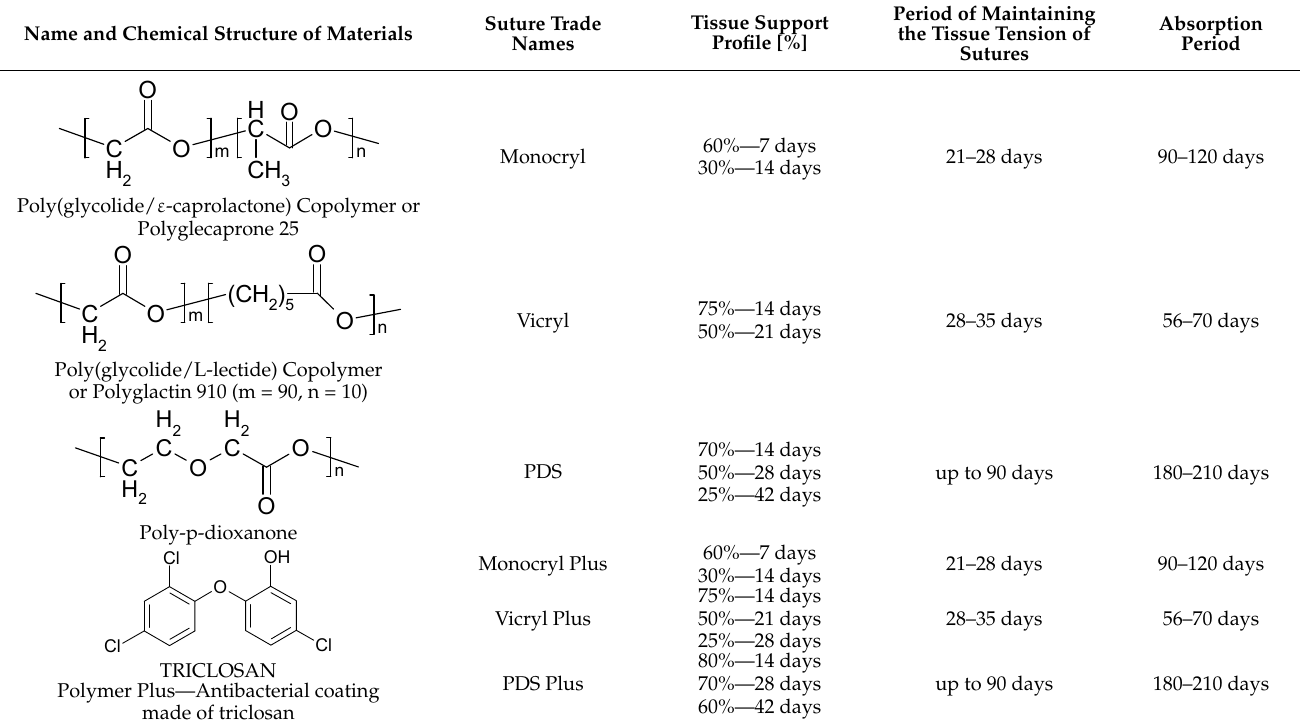
Table 1. Characteristics of absorbable surgical sutures with and without an antibacterial coating (data from suture manufacturer’s leaflet: Ethicon, Johnson&Johnson).